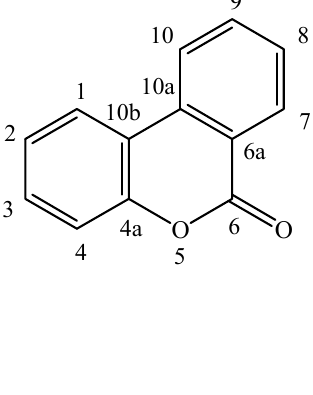
Figure 1. The basic skeleton of dibenzo- α -pyrones.